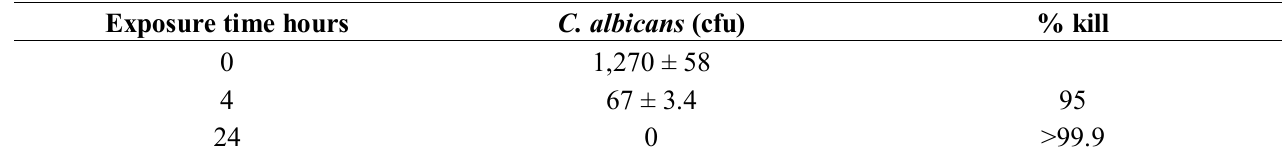
Table 2. Activity of CLO vapor against Candida albicans .